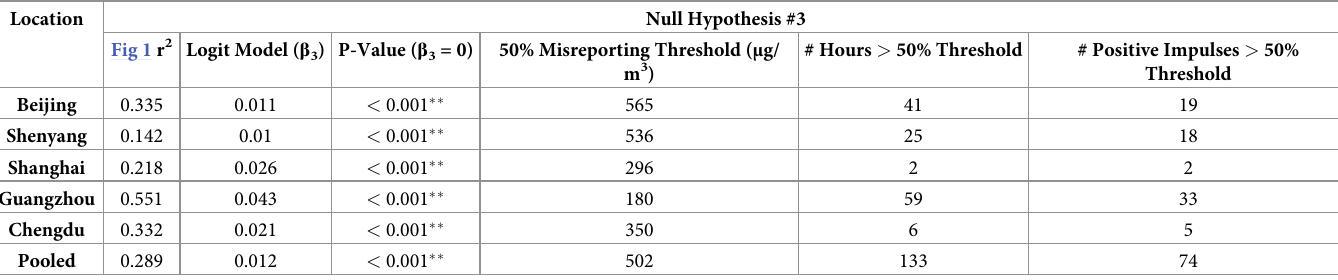
Table 3. Test of null hypothesis #3 for the five Chinese cities and pooled model. Location Null Hypothesis #3 Fig 1 r 2 Logit Model ( β 3 ) P-Value ( β 3 = 0) 50% Misreporting Threshold ( μ g/